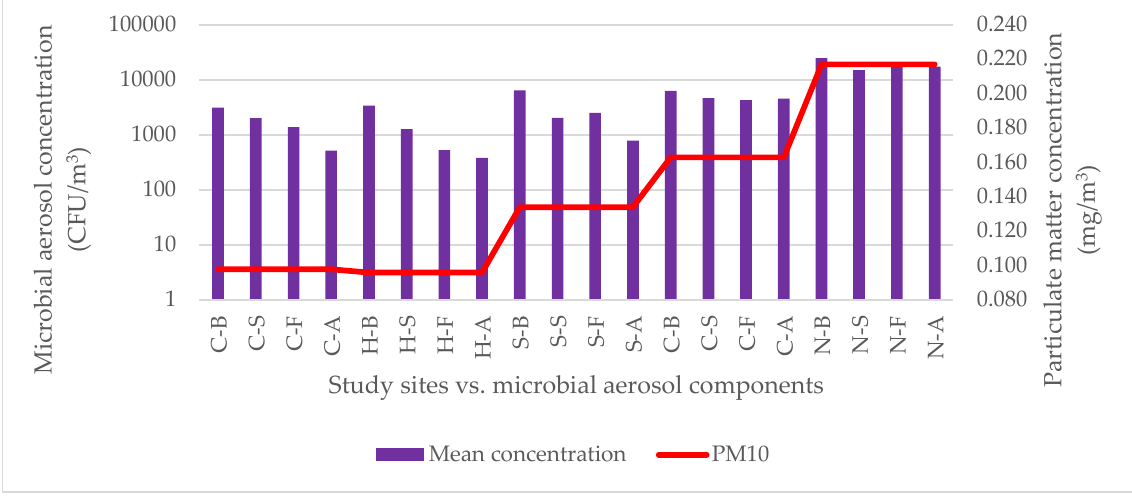
Figure 5. Mean concentration of total microbial aerosol (CFU/m 3 ) in the examined points compared with the concentration of PM 10 (mg/m 3 ). Explanation of symbols used: C—classroom; H—sports hall; S—stable; C—cowshed; N—newborn calf shed; B—bacteria; F—fungi; S—staphylococcus; A—actinomycetes.